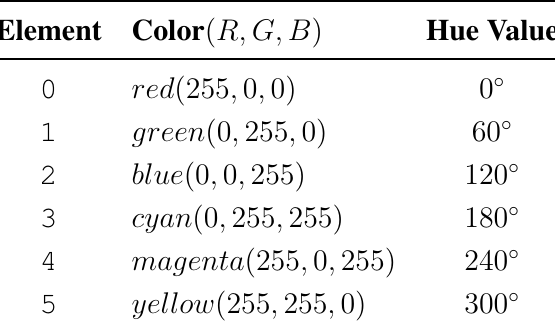
Table 1. Color assignment for each element.